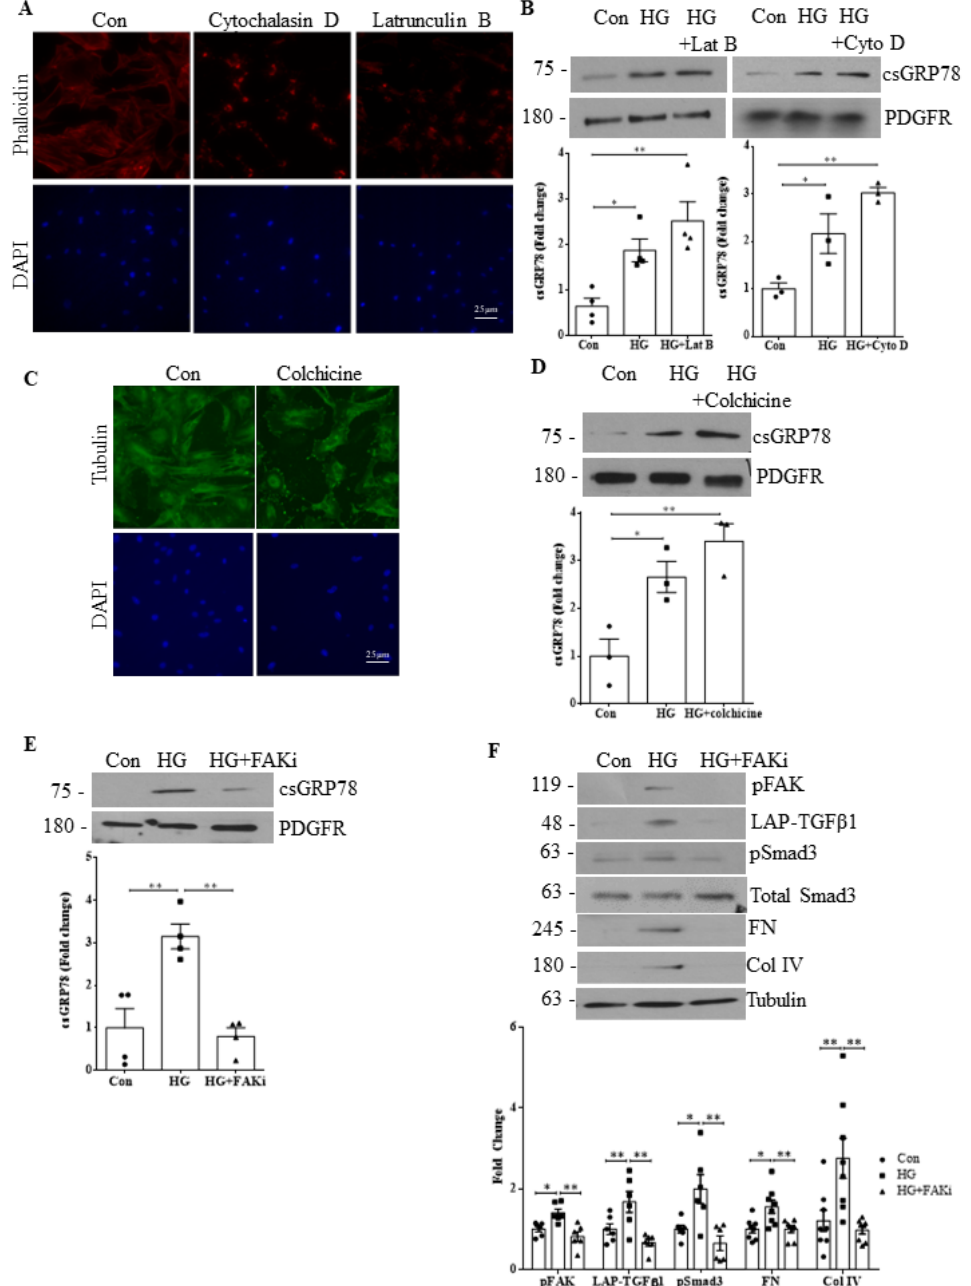
Figure 7. HG-induced csGRP78 translocation is independent of cytoskeleton organization. ( A ) Cells were stained with rhodamine phalloidin to visualize actin filaments, confirming actin cytoskeleton disruption using F-actin inhibitor cytochalasin D (200 ng/mL, 1 h) and G-actin polymerization inhibitor latrunculin B (400nM, 1 h). ( B ) HG (6 h)-induced csGRP78 localization was not affected by either inhibitor ( n = 4 for Lat B and n = 3 for Cyto D, * p < 0.05, ** p < 0.01). ( C ) Cells were stained with tubulin to visualize microtubule filaments, confirming disruption using colchicine (5 µg/mL).